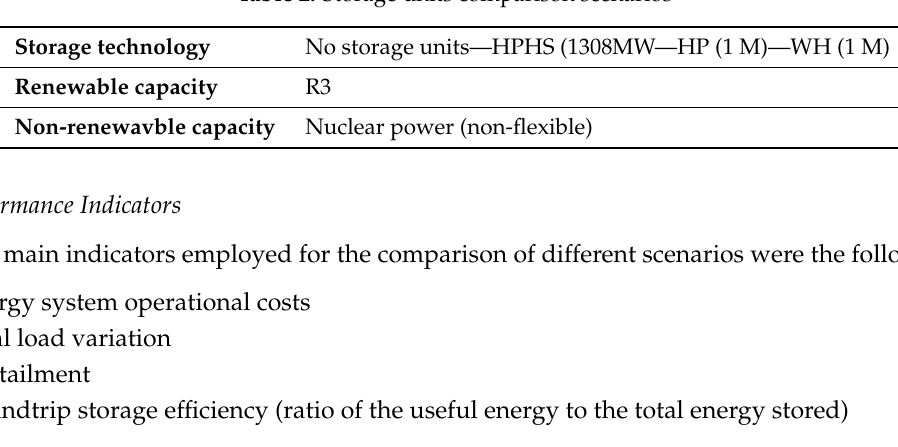
Table 2. Storage units comparison scenarios